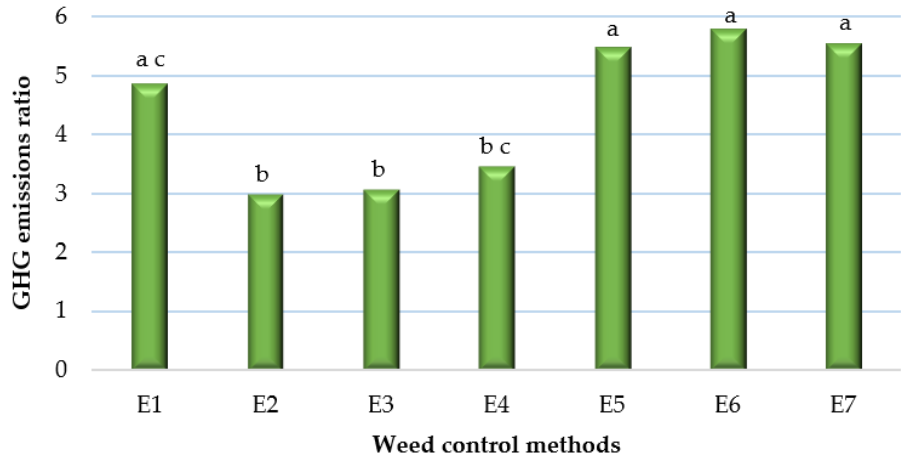
Figure 7. The impact of weed control methods on GHG emissions ratio.